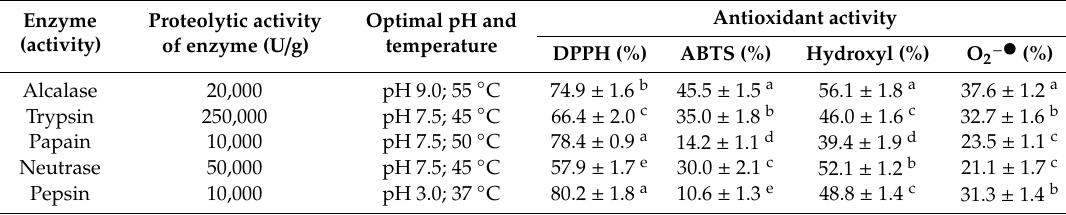
Table 1. The optimal conditions for the hydrolysis of Po SMP by di ff erent enzymes and the antioxidant activity of the di ff erent enzymatic